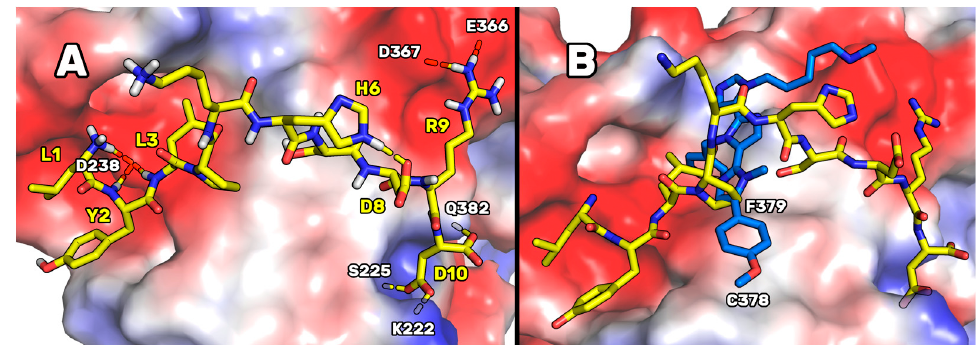
Figure 2. ( A ) Expected binding mode of [I2Y-A9R]P5 (i.e., P5-Best) on the PCSK9 surface resulting from the MD simulations and cluster analysis. Yellow dotted lines depict the H-bond network. The enzyme solvent-accessible surface is colored according to the partial charge of the residues: blue for positive areas and red for negative areas. P5-Best is represented as yellow sticks. ( B ) Superimposition of P5-Best and Rim13, both bound on the PCSK9 surface.